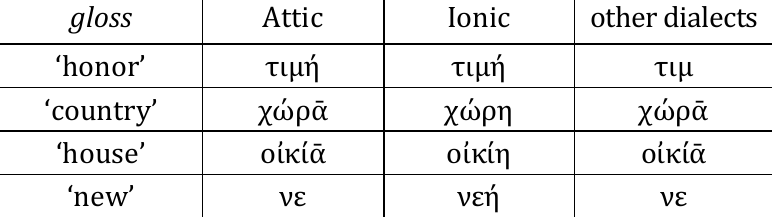
Table 1: Correspondences between Attic, Ionic, and common Greek